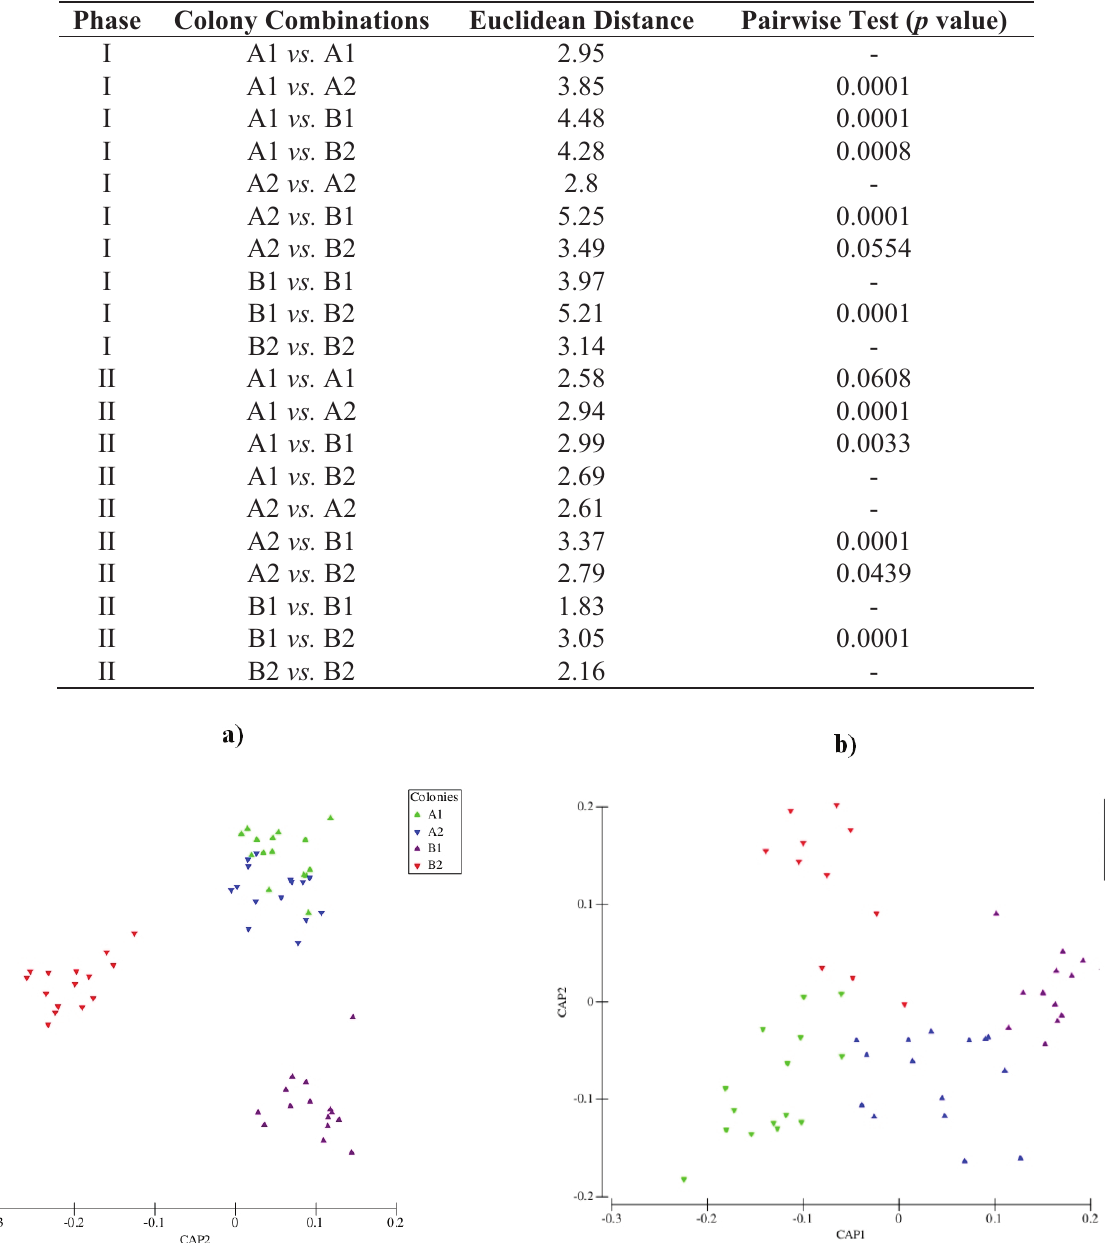
Table 2. Euclidean distance and Pairwise tests carried out with the cuticular hydrocarbon profiles of A. sexdens colonies (A1, A1, B1 e B2) at the Phase I and II of the experiment.